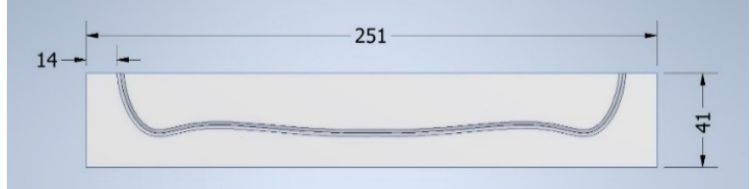
Figure 25. The model no. 1.